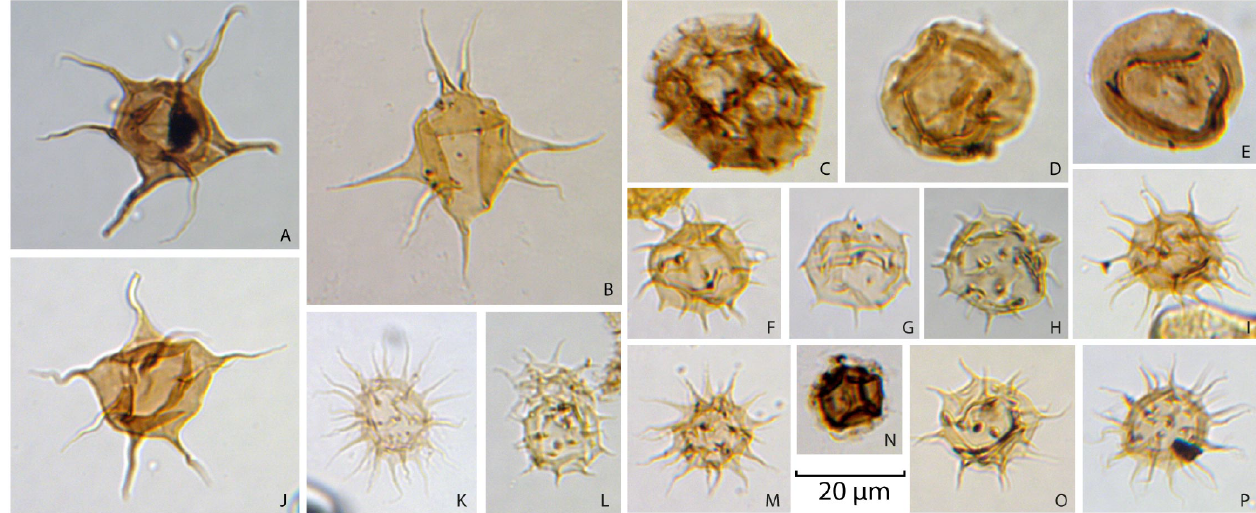
Figure 3. Aquatic palynomorph from the studied interval. (a) M. pentagonale group, (b) V. laidii group, (c) Cymatiosphaera sp., (d, e) leio- spheres, (f–i) M.breve group, (j) M. pentagonale group, (k–m) M. breve group, (n) Cymatiosphaera sp. and (o, p) M. breve group.